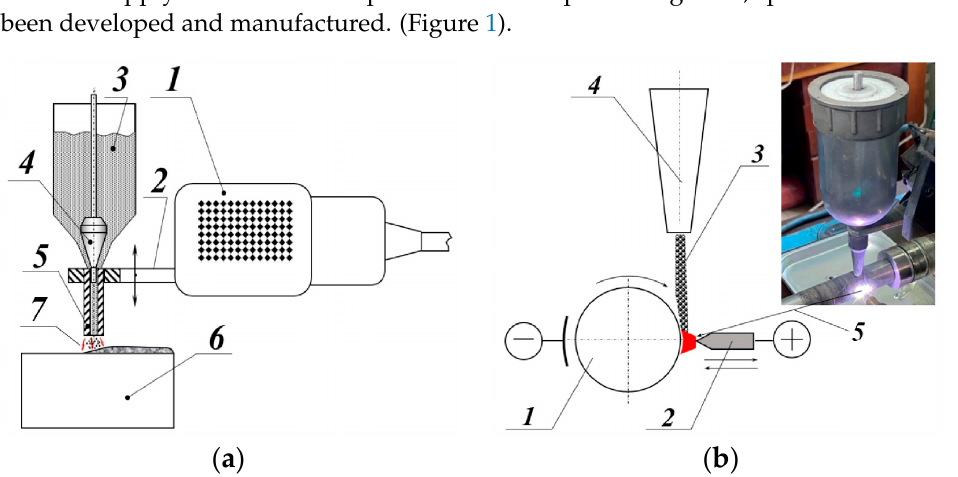
Figure 1. Schematic diagram of the technological methods of electrospark alloying with powder materials: ( a ) for flat surfaces (1—body; 2—anchor; 3—powder hopper; 4—jet; 5—hollow electrode; 6—substrate-cathode); 7—electrical discharge; ( b ) for cylindrical parts: (1—workpiece; 2—electrode-tool; 3—powder material; 4—powder hopper; 5—electrical discharge).